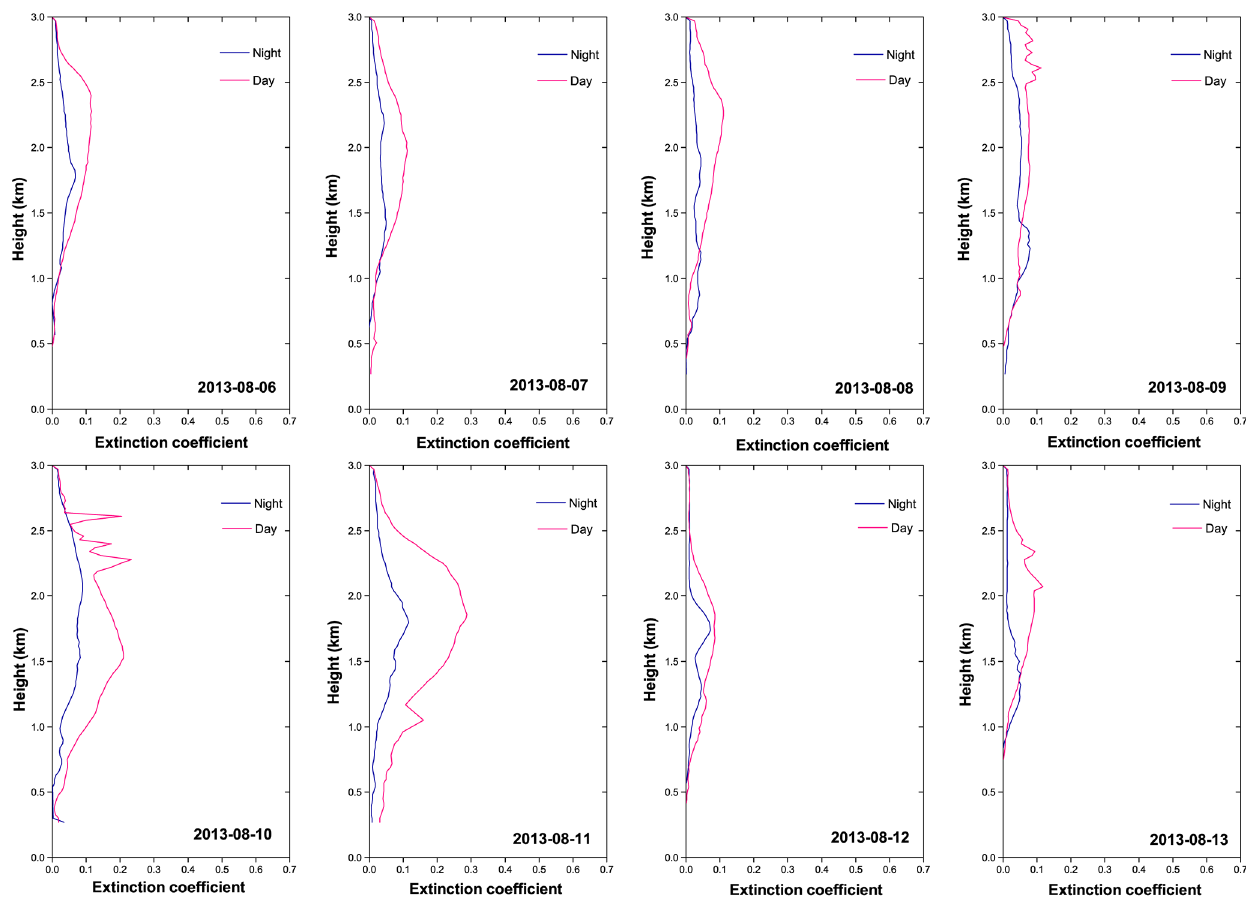
Figure 11. Profiles of the aerosol extinction coefficient from MPL-retrieved data averaged for daytime and nighttime during 6–13 August 2013 in